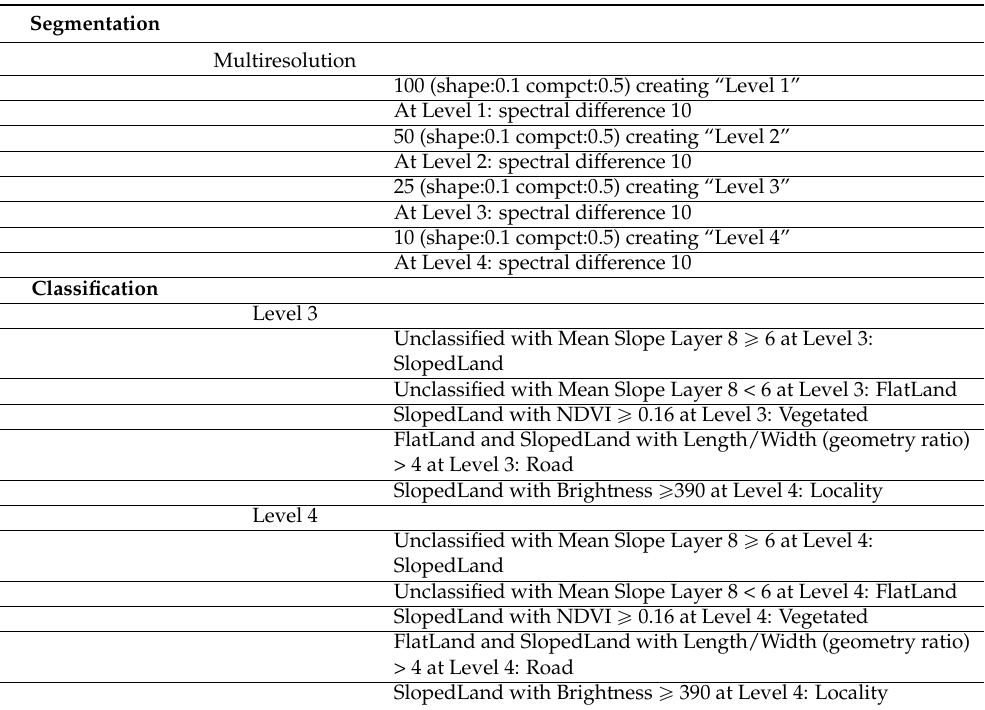
Table 1. eCognition rule set for the QuickBird